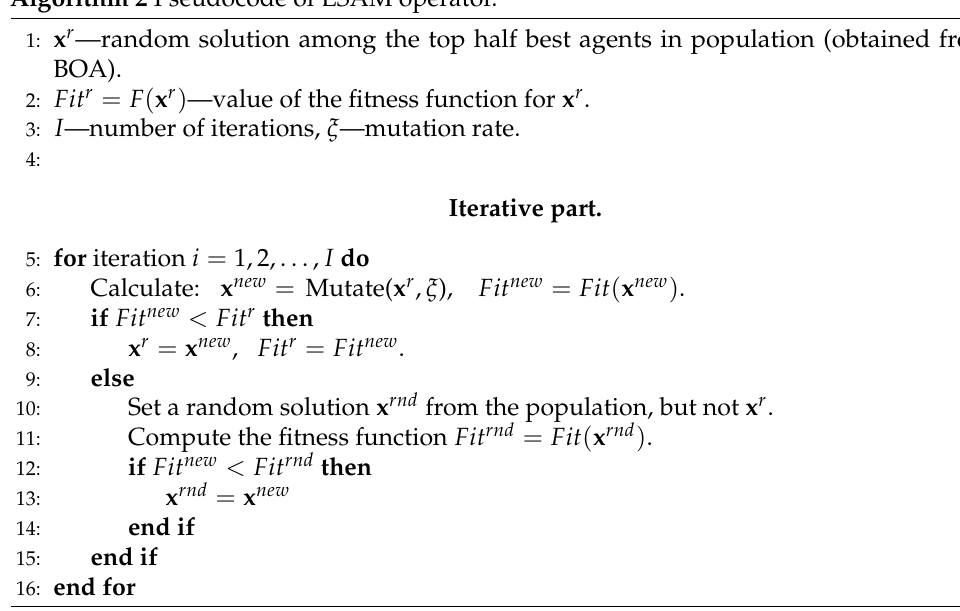
Algorithm 2 Pseudocode of LSAM operator.